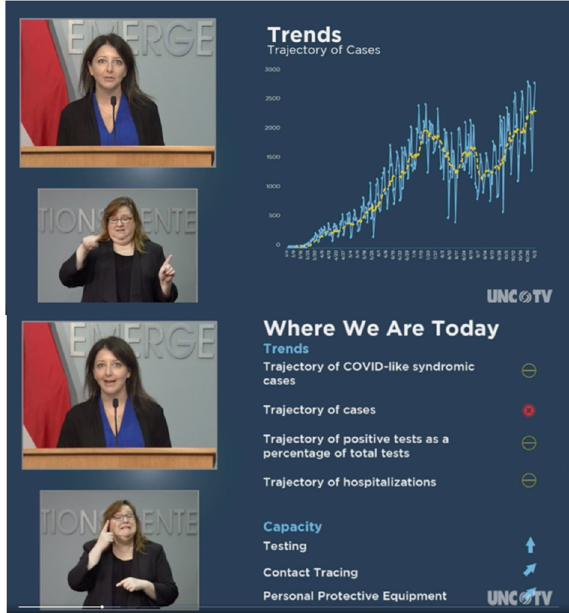
Fig. 2 Screen images of the media brie fi ng on November 5,